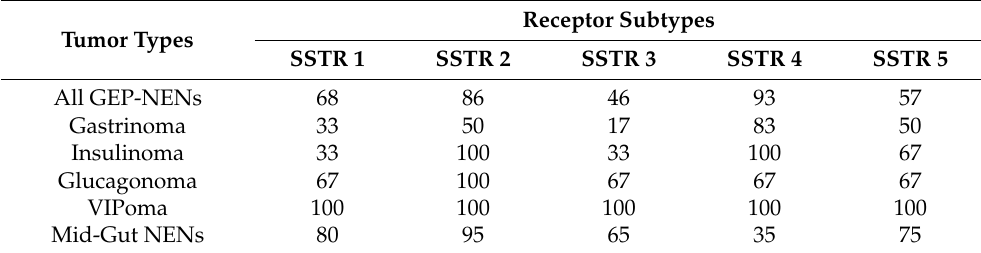
Table 3 lists the frequency of overexpression of different SSTR subtypes in different clinical presentations [27]. Table 3. Expression of somatostatin receptors in different GEP-NENs (%). Tumor